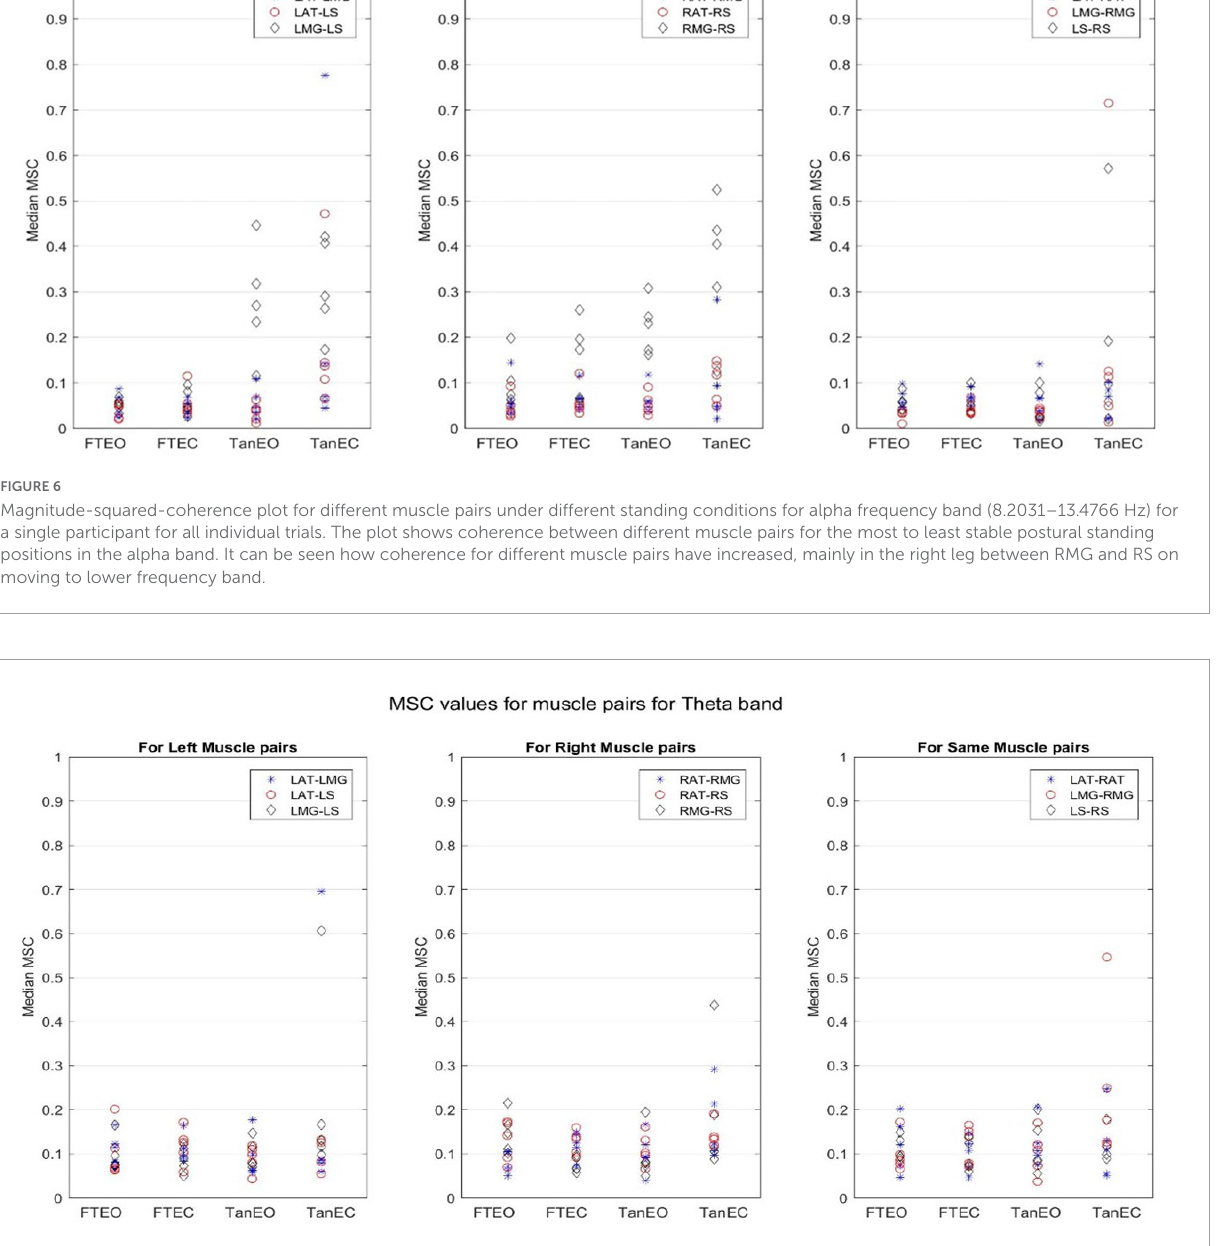
FIGURE7 Magnitude-squared-coherence plot for different muscle pairs under different standing conditions for theta frequency band (4.1016–8.2021 Hz) for a single participant for all individual trials. The plot shows coherence between different muscle pairs for the most to least stable postural standing positions in the theta band. It can be seen how coherence for different muscle pairs have increased on moving to lower frequency